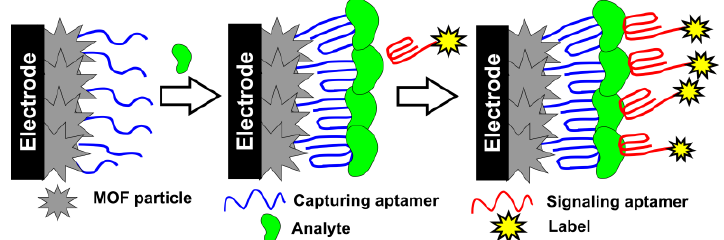
Figure 9. Detection of aptamer–analyte interaction with sandwich analysis using redox-active label.